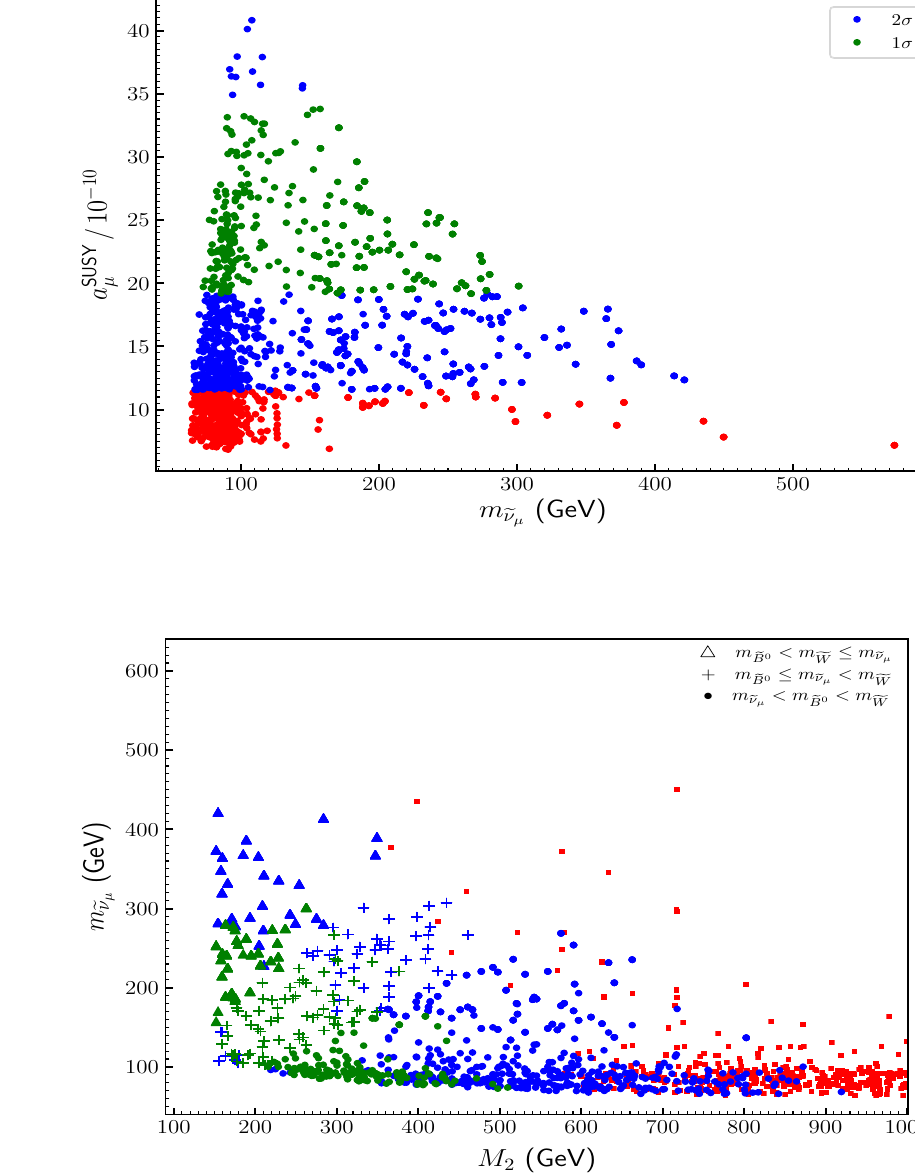
Fig. 8 a SUSY μ versus m (cid:2) ν μ from the scan of Tables 2 and 3. The color code is the same as in Fig. 6